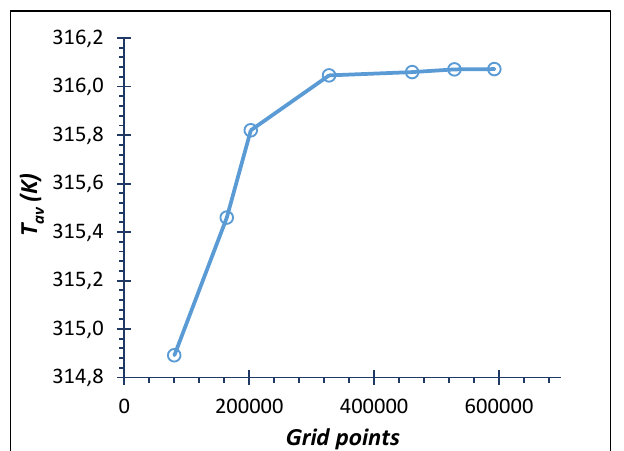
Figure 6: Residuals plot.